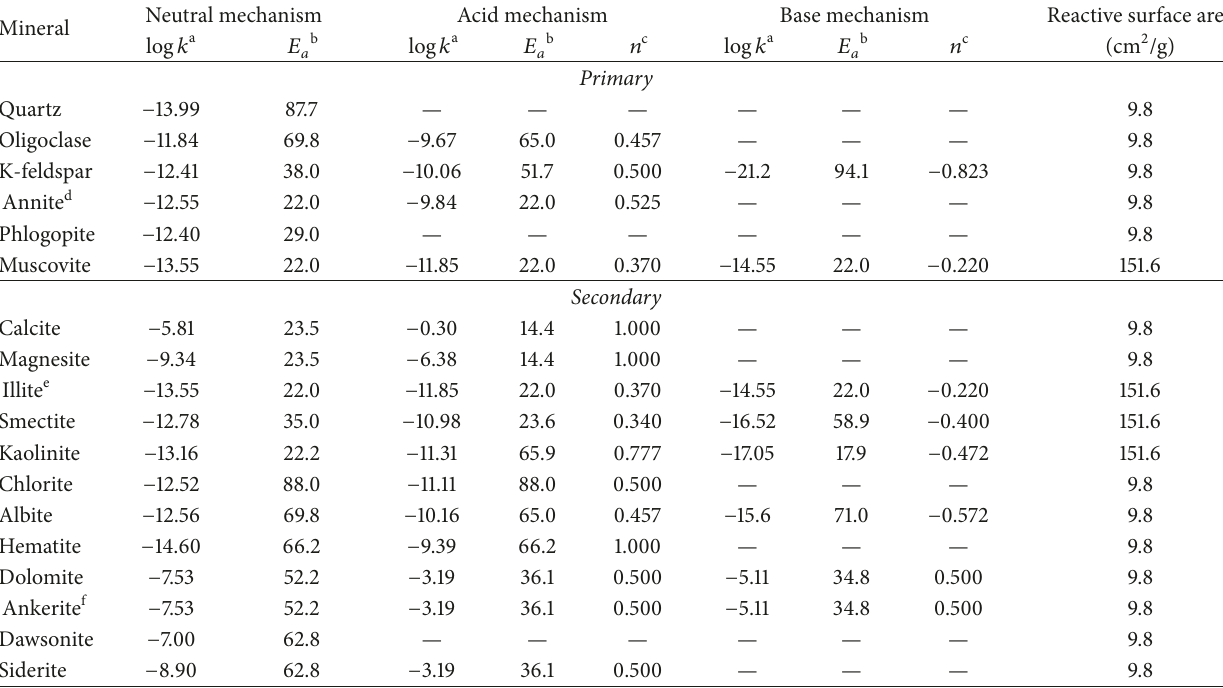
Table 4: Kinetic rate parameters of primary and secondary minerals and reactive surface area for the geochemical simulations of the St. John’s CO 2 research